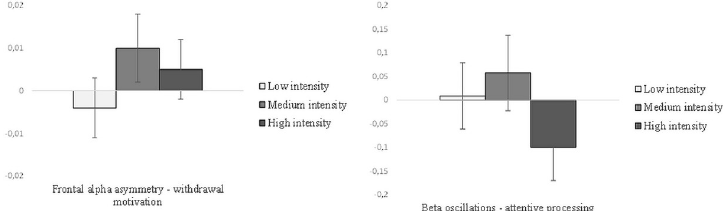
Fig 5. Frontal alpha asymmetry and beta oscillations as a function of the intensity of negative emotions in the social campaign. Error bars represent ± 1 standard errors.